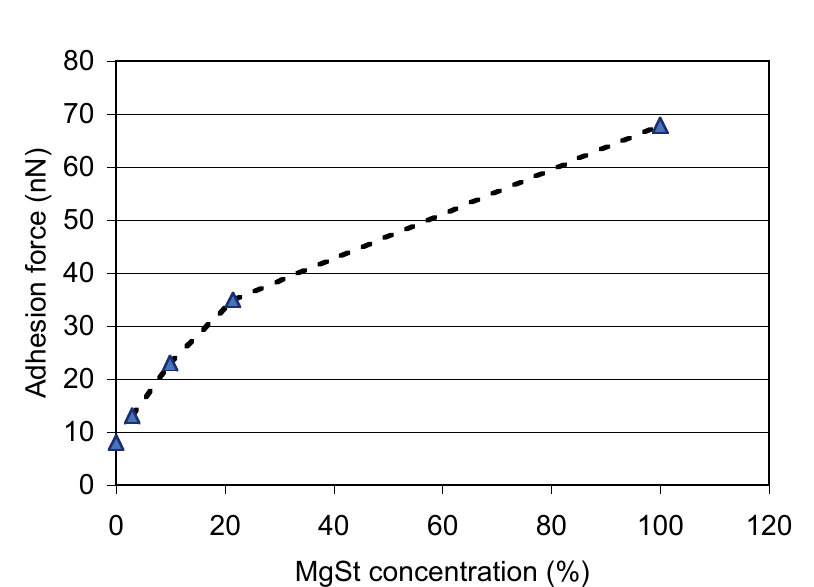
concentration. 2